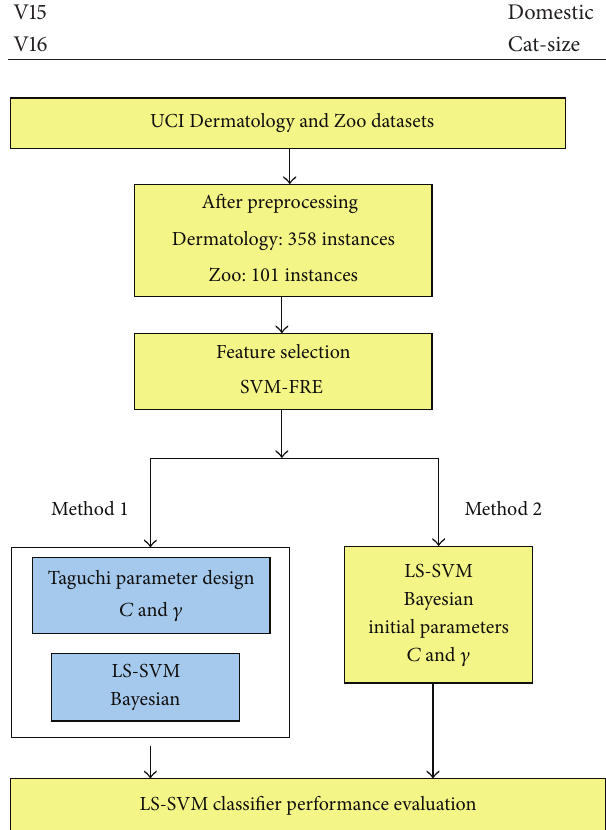
Figure 1: Research